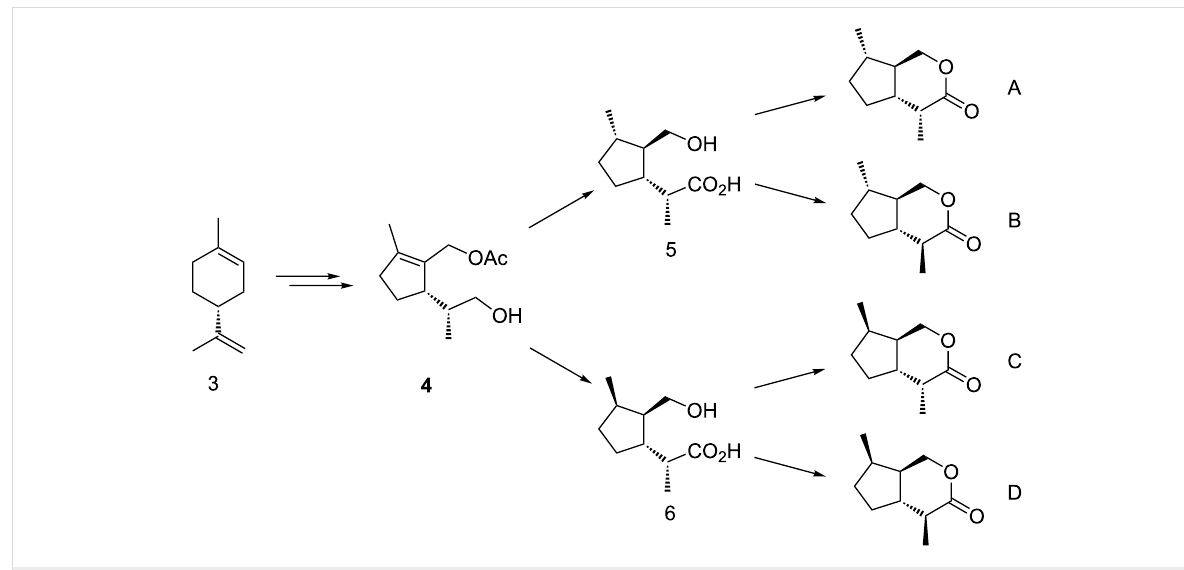
Figure 4: Strategy for the stereoselective synthesis of trans -fused iridomyrmecins A – D from ( R )-limonene.